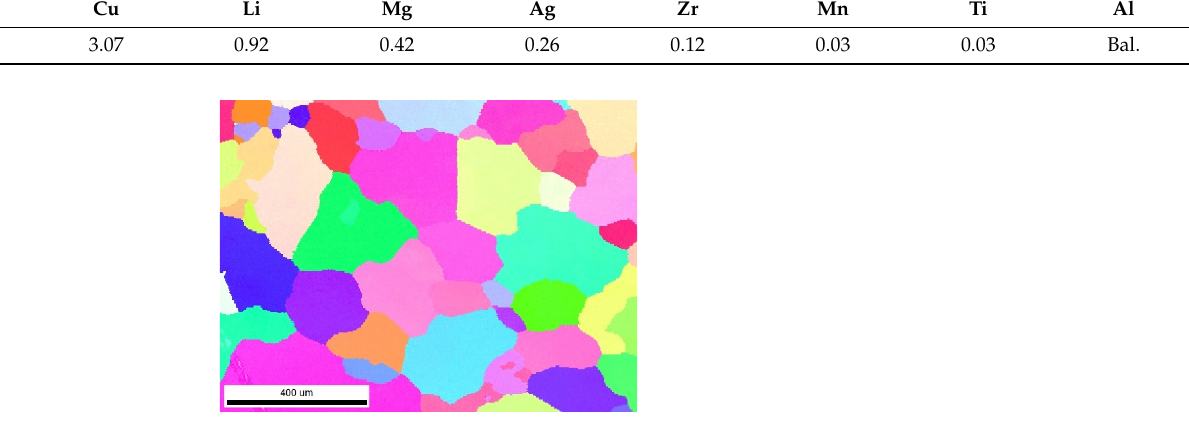
Figure 1. IPF map of the homogenized 2198 Al–Li alloy without compression.